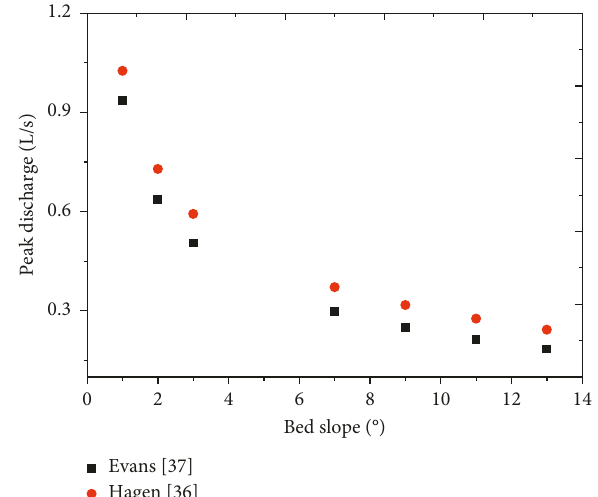
Figure 12: The relationship between calculated peak discharge values with Evans’s and Hagen’s methods [36, 37] and bed slopes.